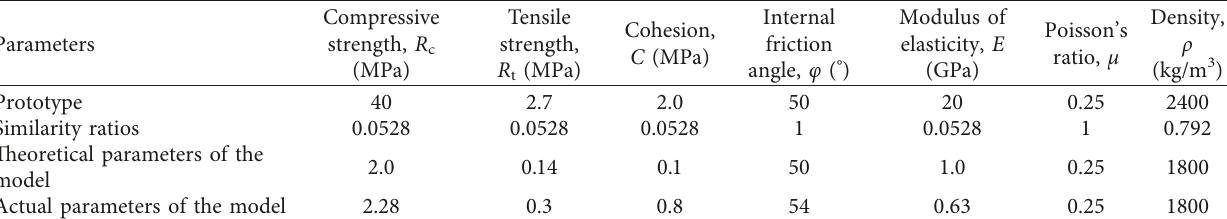
Table 2: The principle of determining physical model